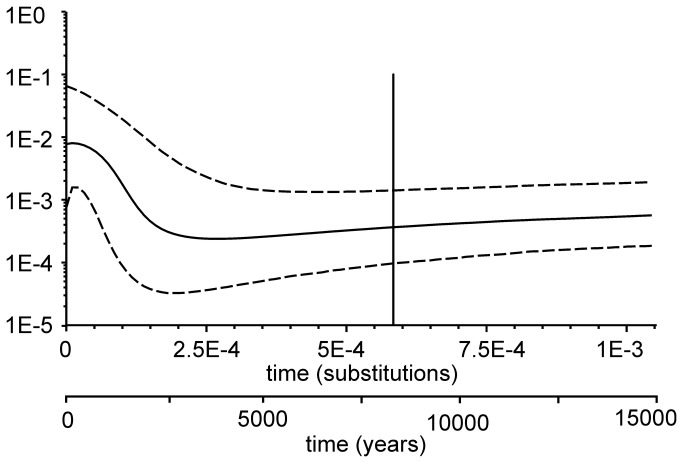
Bayesian Skyline Plot of population dynamics of the Carpathian barbel.Thick curves represent mean inferred effective population size, dashed curves mark the 95% highest probability density (HPD) intervals. Vertical line – mean mitochondrial tMRCA estimate of the whole species.